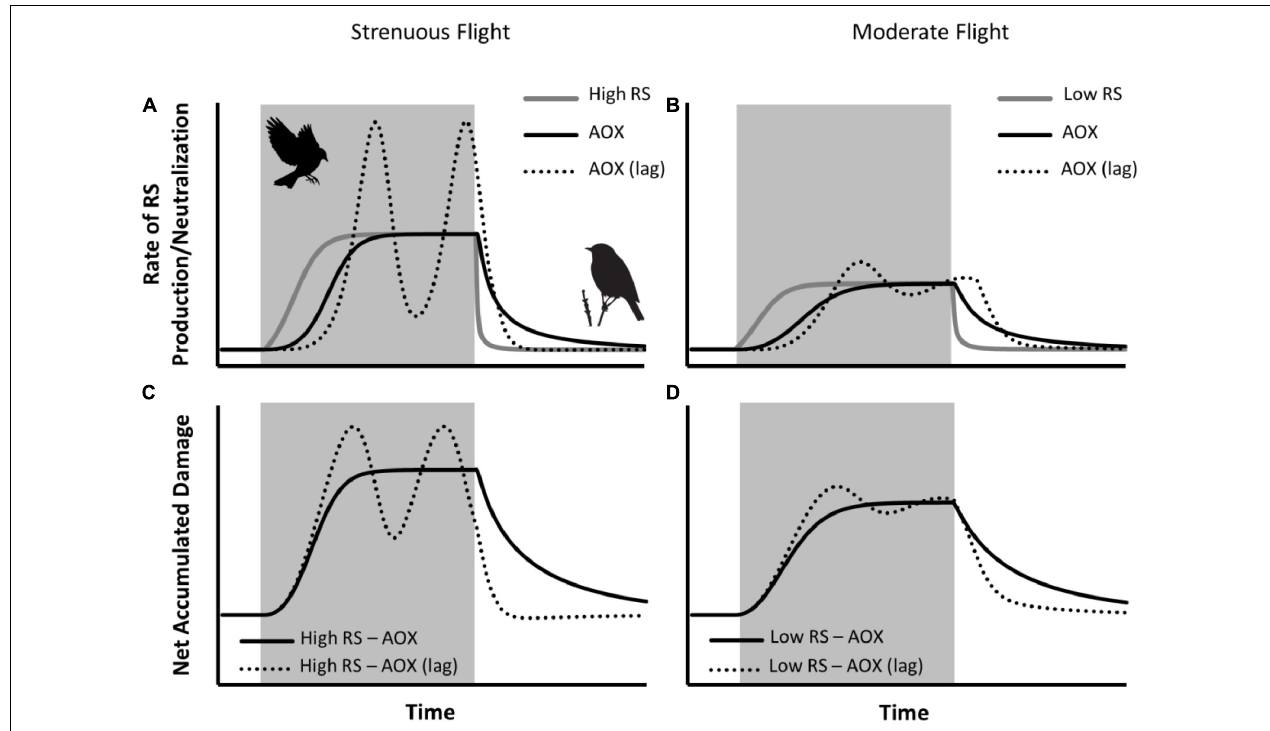
FIGURE 4 | Conceptual model of the accumulation of RS byproducts measured by oxidative damage assays. The cumulative sum of the rates of RS production and neutralization over time (A,B) produce the net accumulated oxidative damage at a given time point (C,D) . The rate of RS production increases to a set level during flight (shaded areas) and then decreases during recovery, with the set level higher for more strenuous flight (A) than moderate flight (B) . The rate of scalable antioxidant activity changes exponentially in response to accumulated damage, and therefore rates of RS neutralization (AOX) also vary between strenuous and moderate flight. Moreover, the rate of RS neutralization becomes more variable and increases more dramatically with a greater delay in response time [AOX (lag)]. Subsequent measurements of oxidative damage will depend on the responsiveness of the antioxidant system and the timing of the measurement, with strenuous flight (C) sometimes resulting in lower measurements of damage than moderate flight (D)